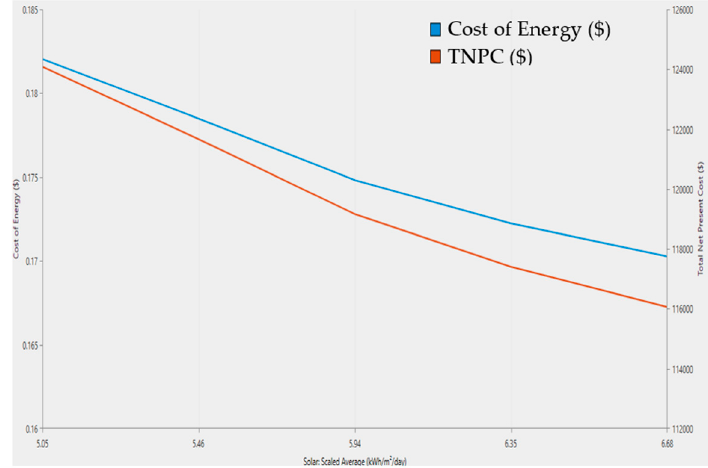
Figure 17. LCOE and TNPC related to GHI variations.